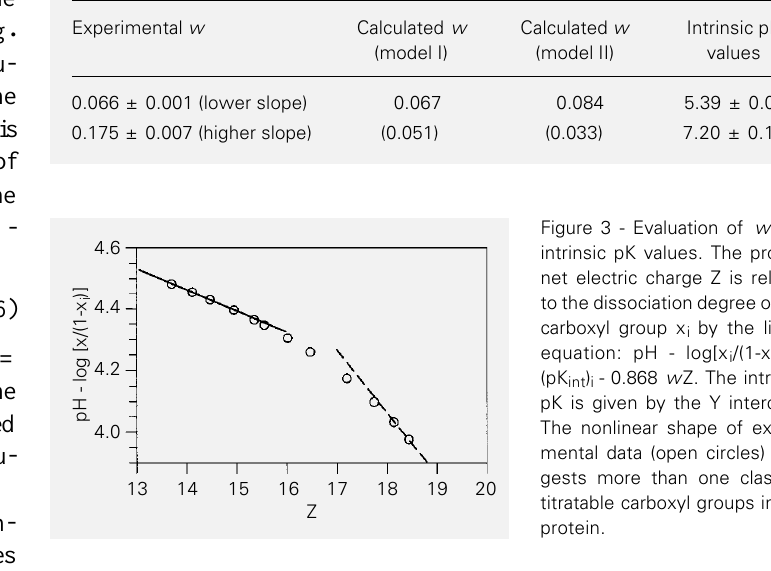
Table 2 - Calculated and experimental w and intrinsic pK values for the titration data of ß-trypsin. Experimental w